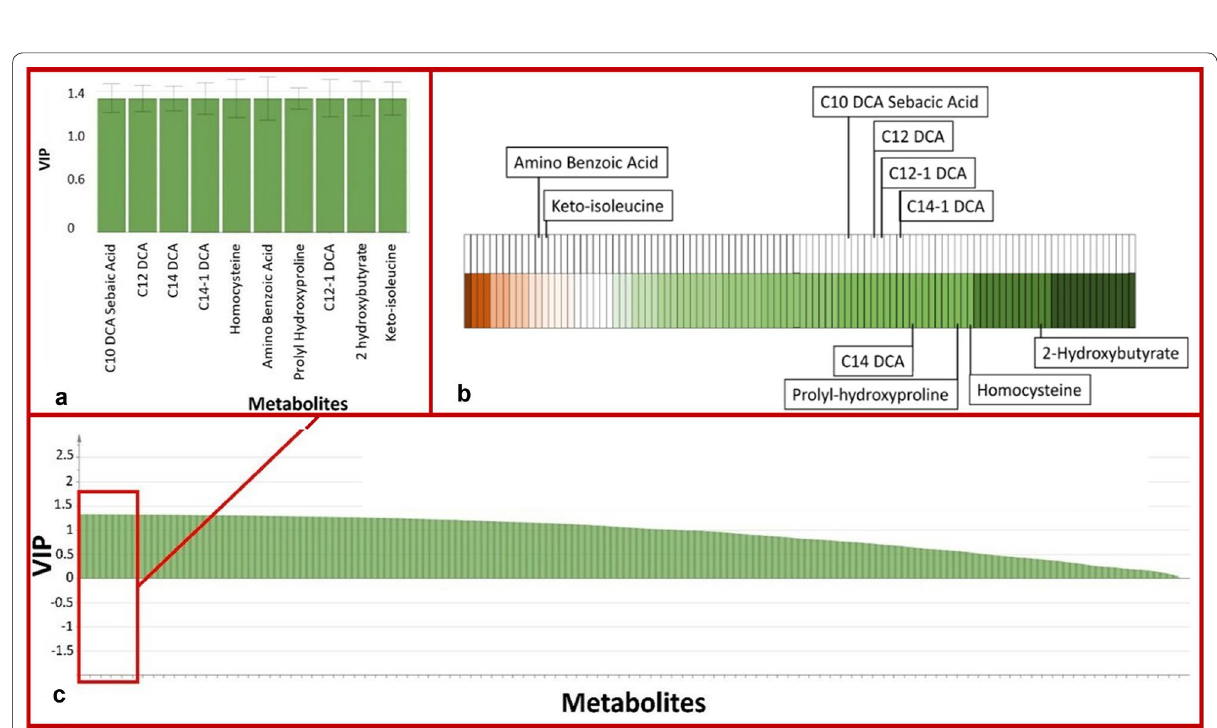
Fig. 3 VIP Plot and Correlation Heat Map generated from BLM model (R2X (cum) generated from the BLM model using a PLS approach includes all the metabolites analyzed in the study ( c ). For simplicity, a cut-away of the VIP plot displays the top 10 metabolites in closer detail ( a ). A correlation matrix in the form of a heat map ( b ) displays the relative metabolite correlations to titer as positive (green) or negative (red). Highlighted in boxes are the locations of the top ten metabolites identified from the VIP